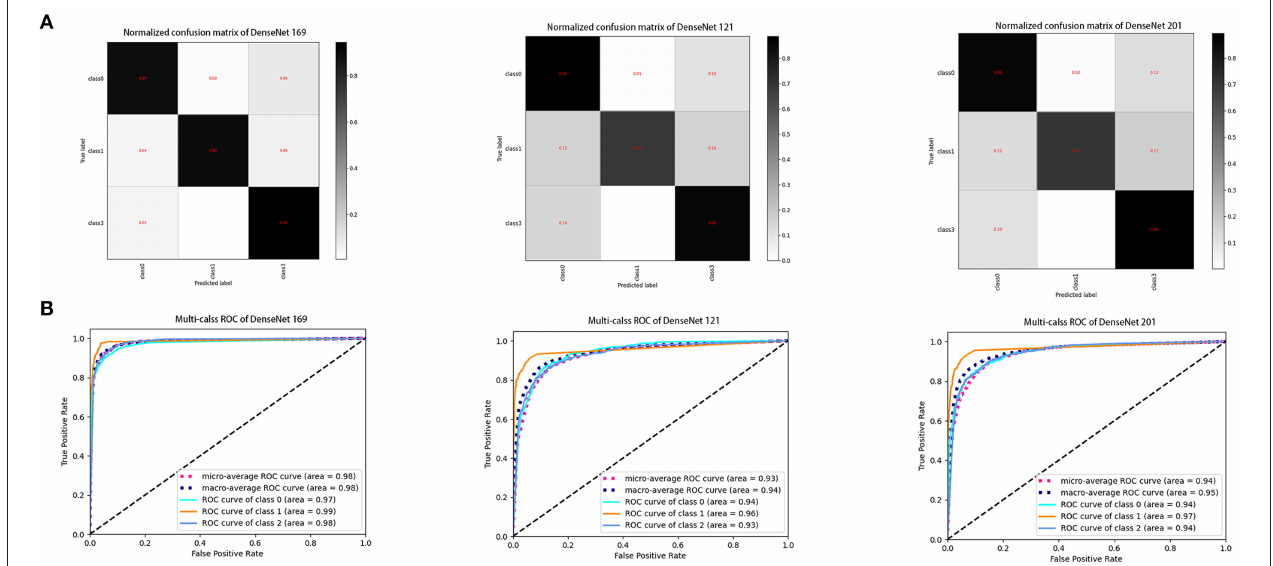
FIGURE 6 | Performance of three DenseNet deep learning algorithms in the test dataset. (A) Confusion matrices describing the accuracies of deep learning algorithms. (B) Receiver operating characteristic curves indicating the performance of each algorithm in diagnosis of obstructive MGD, atrophic MGD and healthy controls. DenseNet 169 model demonstrated the highest differential diagnostic accuracy. Class 0: obstructive MGD; class 1: atrophic MGD; class 2: healthy controls. MGD, meibomian gland